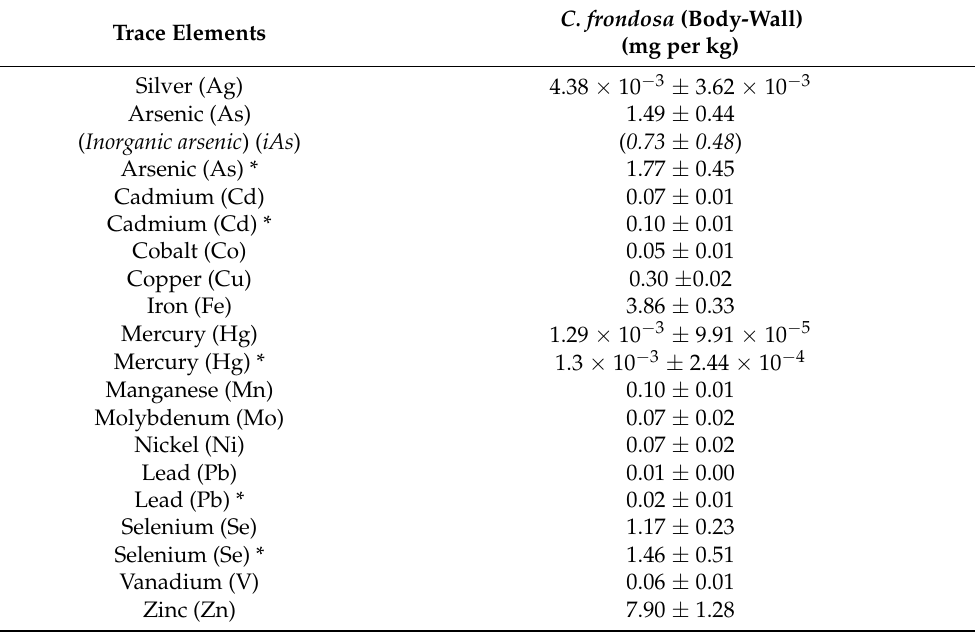
Table 4. Trace elements composition (mg per kg) of wet weight orange-footed sea cucumber ( Cucumaria frondosa ) body-wall (average ± SD, n = 4). All values below or equal to the level of detection (LOD) were set equal to